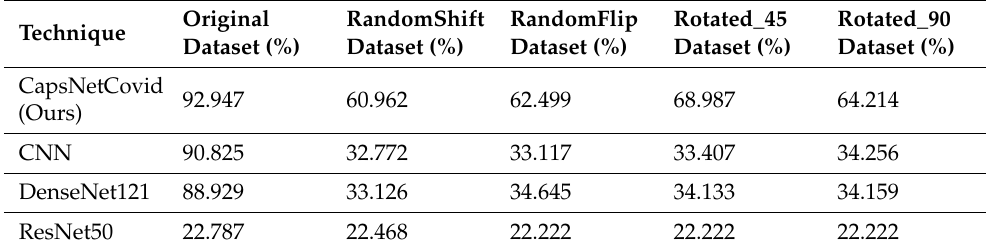
Table 13. Sensitivity for CapsNetCovid, CNN, DenseNet121, and ResNet50 for multi-class classification. Technique